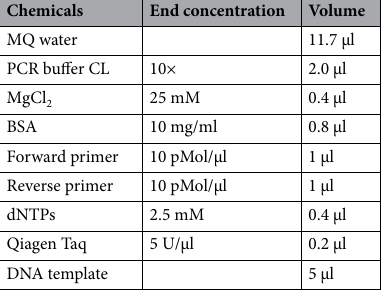
Table 2. Chemicals used for amplification of foraminiferal COI fragments; concentrations and volumes are shown per sample.